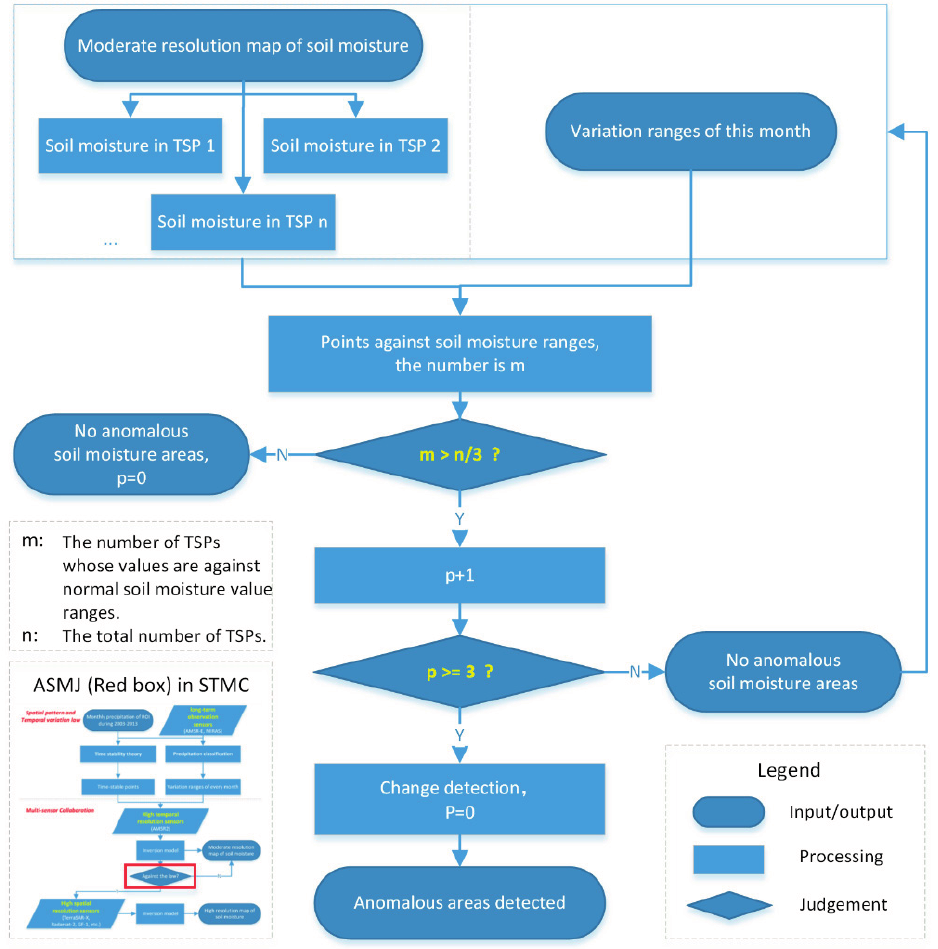
Figure 4. Details regarding the ASMJ algorithm. The TSPs and variation ranges are used to judge the normal or anomalous soil moisture distributions in the region. The change detection is used to target the anomalous areas. The role of the ASMJ algorithm in the STMC method is illustrated in the lower left. The parameter m is the number of TSPs whose values are against normal soil moisture value ranges. And the parameter n is the total number of